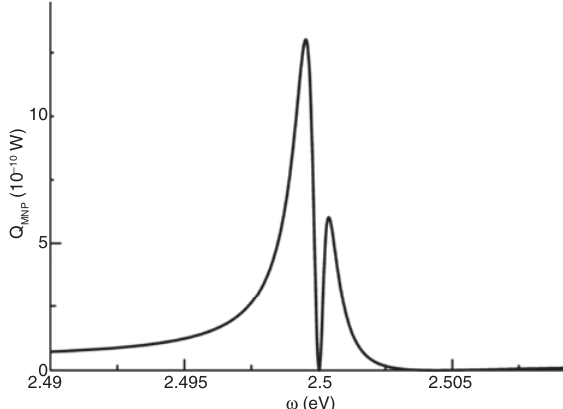
Figure 20: Typical lineshape predicted in the scattering spectrum of coupled PNPs and QDs in the intermediate coupling regime, characteristic of Fano